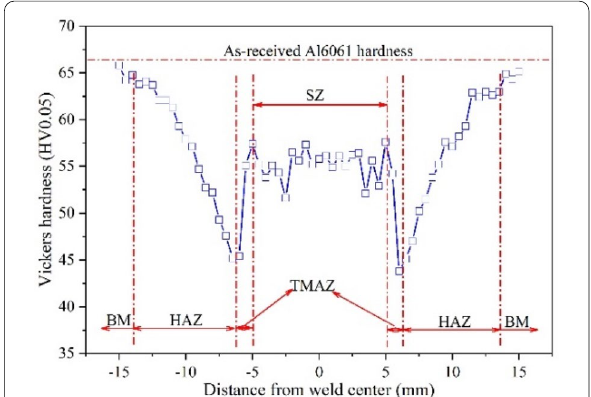
Figure 8 Hardness profile along mid-thickness of Al 6061 sheet